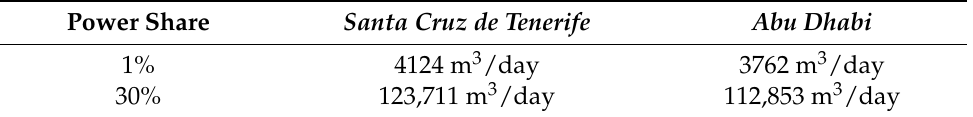
Table 5. Water production in m 3